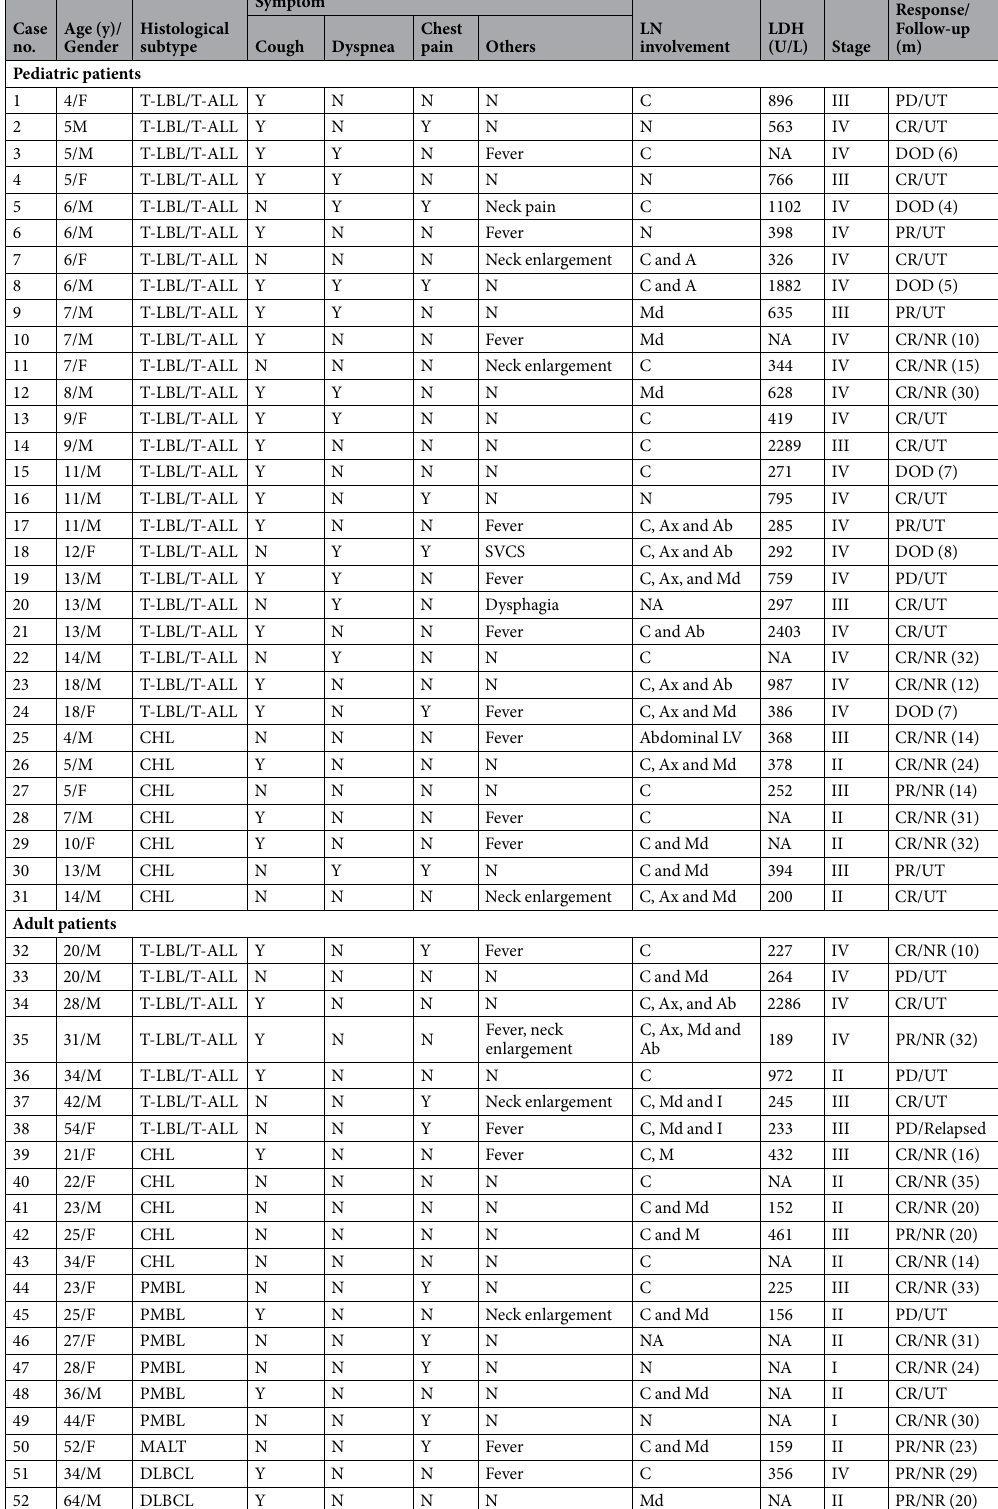
Table 1. Clinical presentations of 52 cases with lymphomas involving the mediastinum. Abbreviations: Ab, abdominal; Ax, axillary; C, cervical; CHL, classical Hodgkin lymphoma; CR, complete remission; D, diffuse large B-cell lymphoma; DOD, dead of disease; F, female; LN, lymph node; I,inguinal; MALT, mucosa associated lymphoid tissue lymphoma; Md, mediastinal node; M, male; N, no; NA, not available; NSCHL, nodular sclerosis classical Hodgkin lymphoma; NR, no relapse; PMBL, primary mediastinal large B-cell lymphoma; PD, progressing disease; PR, partial remission; T-LBL, T-cell lymphoblastic lymphoma/T-cell lymphoblastic leukemia; UT, under treatment; Y, yes; SVCS, superior vena cava